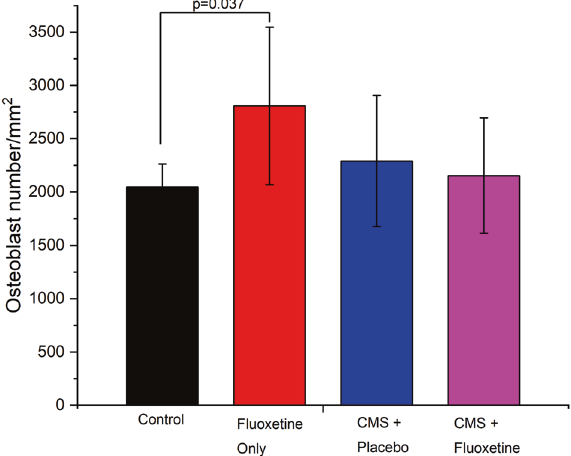
Fig. 6 Osteoblast number within metaphysis region. (1) Control (No CMS + No oral gavage), (2) fl uoxetine-only, (3) CMS + placebo and (4) CMS + fl uoxetine